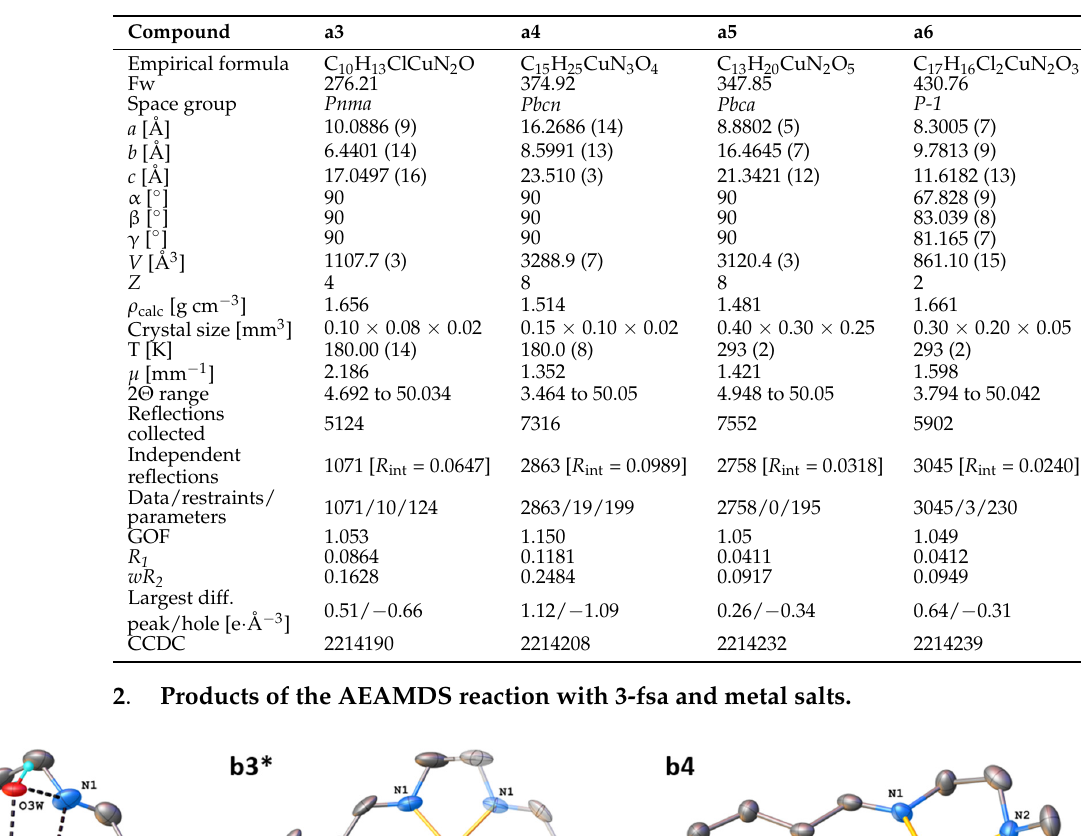
Table 1. Crystal data and details of data collection for the a compounds.